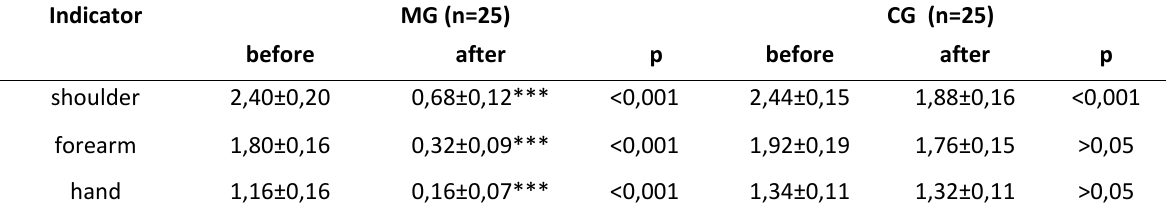
Table 2. Changes of segments’ perimeters of upper limbs (M±m) in main group and comparison group at rehabilitation stationary stage, cm